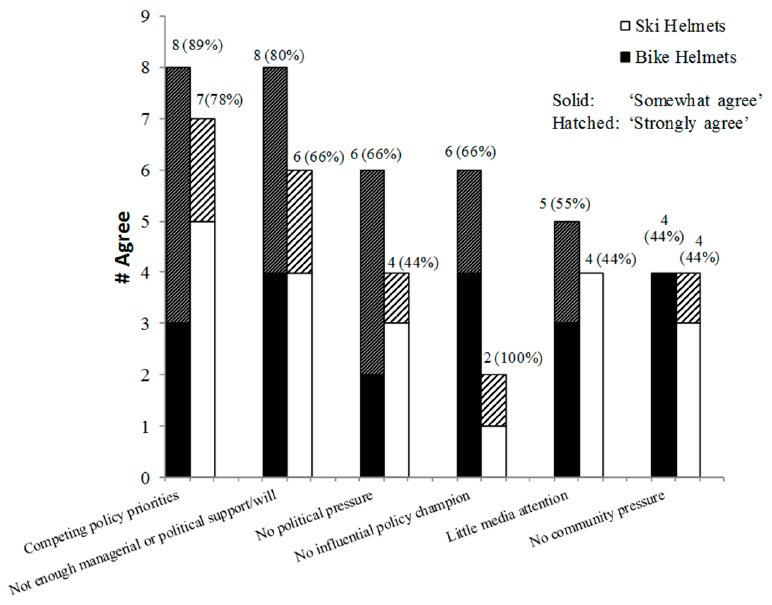
Figure 3. “Ski and bike helmet legislation has not been instituted in my province because….”